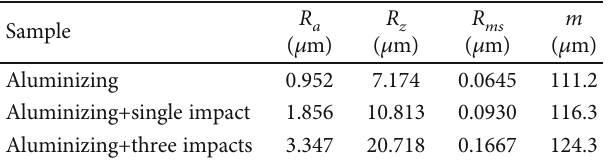
Table 2: Surface roughness values of the aluminized steel with di ff erent times of LSP